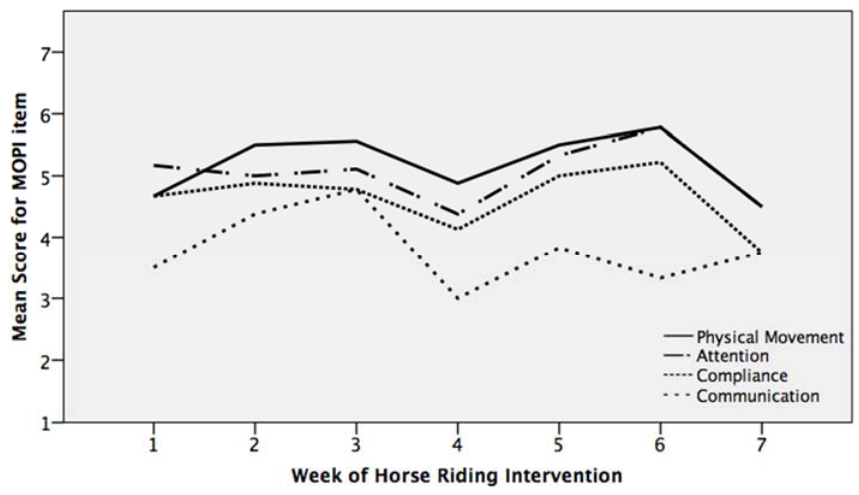
Figure 3. Mean Measurement of Pet Intervention Checklist (MOPI) item scores across the intervention period for the intervention group ( n = 10).